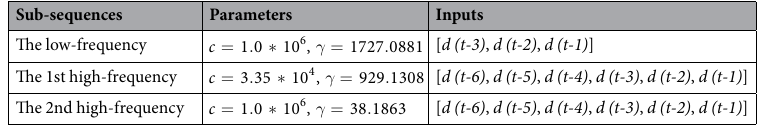
Table 1. The parameters and inputs of the prediction models for sub-sequences. Note: d(t-n) means the displacement of n months ago.